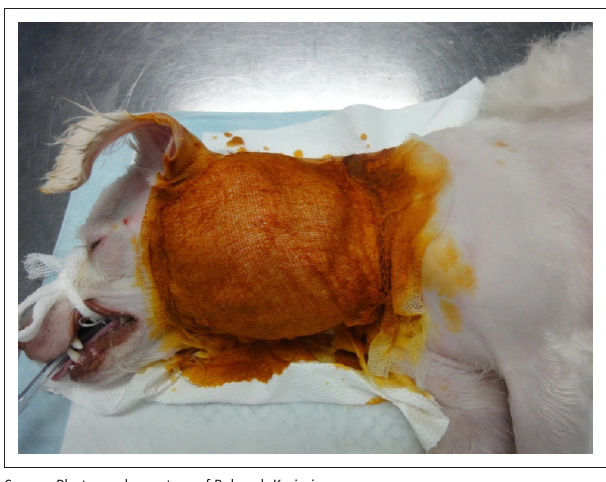
FIGURE 1: Large mass on the left side of the neck, extending from the ramus of the mandible to the thoracic inlet.